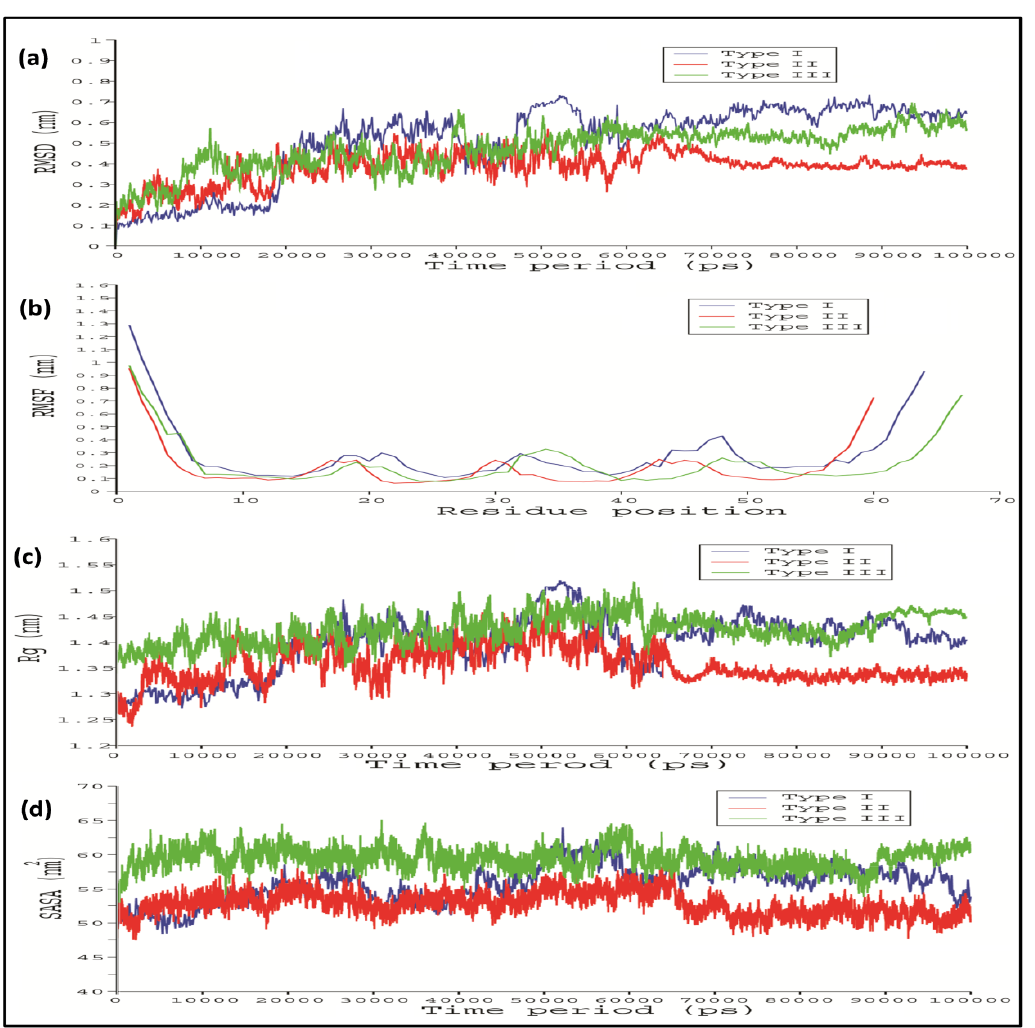
Figure 4. Line diagram showing the ( a ) root mean square deviation (RMSD); ( b ) root mean square fluctuation (RMSF); ( c ) radius of gyration (Rg); and ( d ) solvent accessible surface area (SASA) of Type I, Type II, and Type III CcWRKY DBDs. (Type I in blue, Type II in red, and Type III in green).